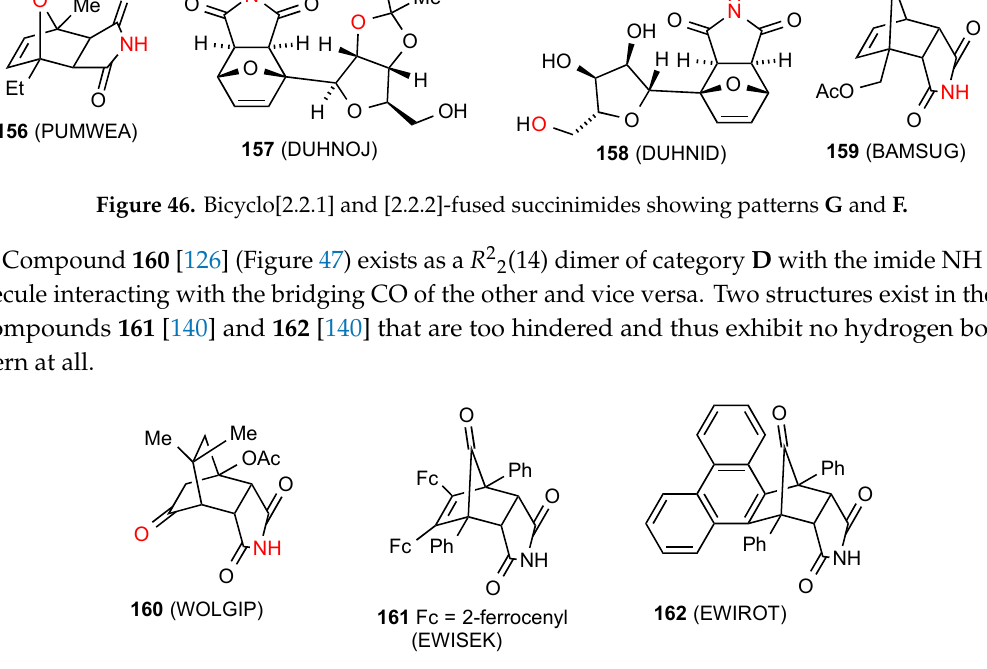
Figure 48. Structure adopted by compound 163.